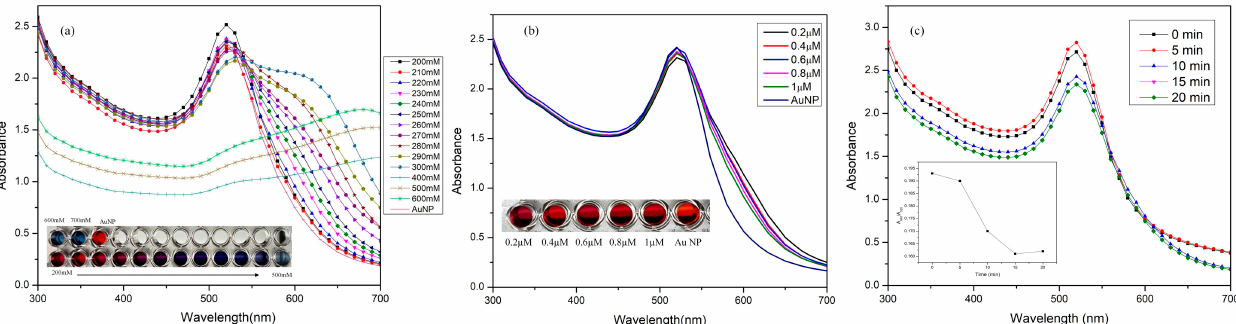
Figure 3. Schematic representation of the working of the prepared paper biosensor, which uses a colorimetric detection approach for gentamicin.